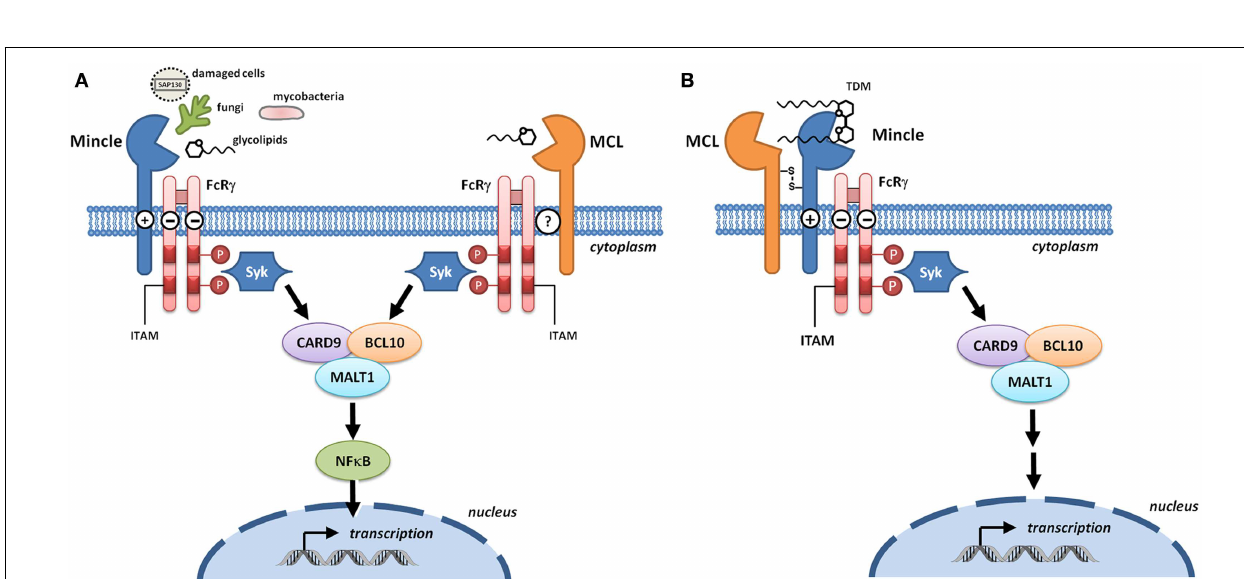
FIGURE 2 | Signaling through Mincle and MCL . (A) Mincle and MCL pair with the signaling adaptor molecule Fc receptor γ -chain (FcR γ ).With Mincle this association is driven by the presence of a positively charged arginine in the transmembrane region whereas the corresponding residue is not present in MCL. Upon binding to DAMPs or fungal and bacterial PAMPs, phosphorylation of the immunoreceptor tyrosine-based activation motifs (ITAMs) of FcR γ recruits spleen tyrosine kinase (Syk)